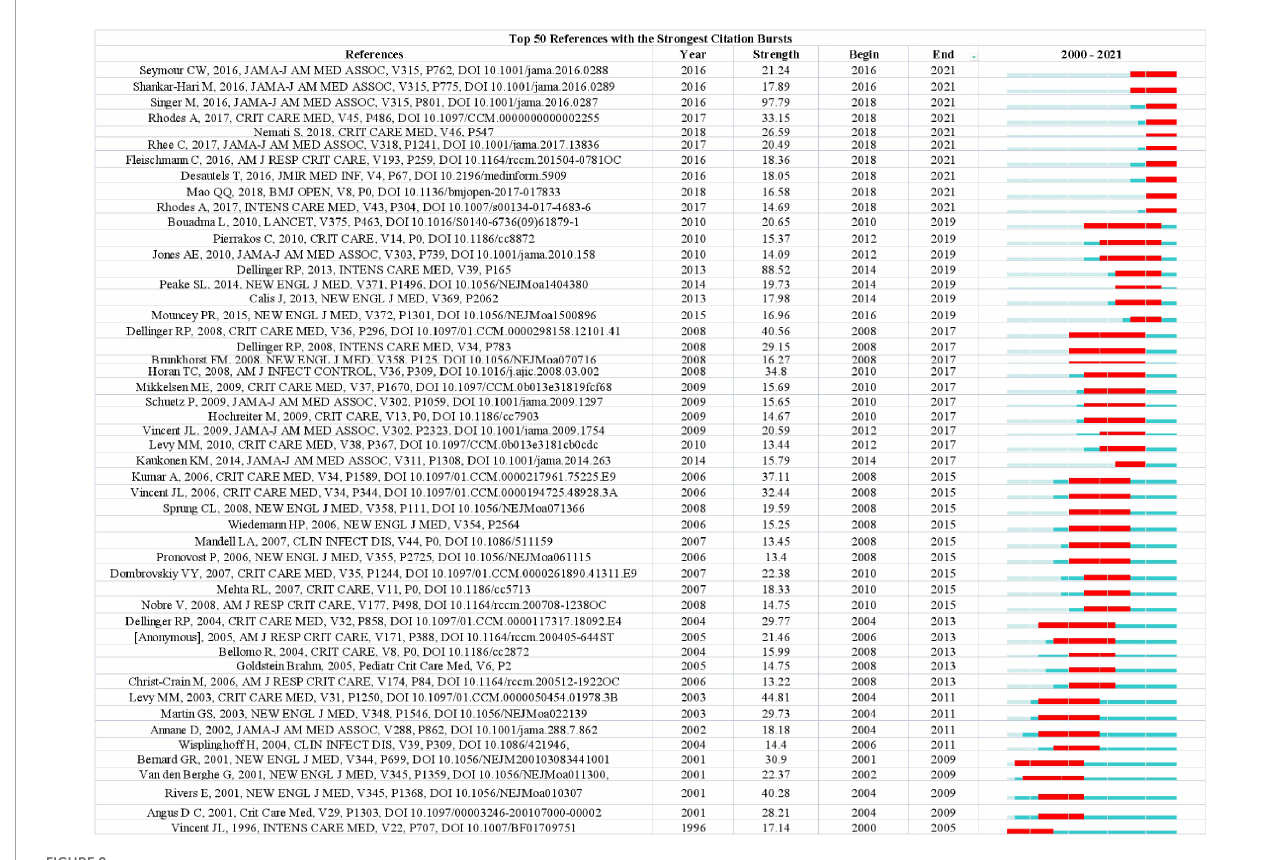
FIGURE8 Ranking of references with the strongest citation bursts related to artificial intelligence in sepsis. The strength values reflect the frequency of citation. Red bars indicate a burst period for the